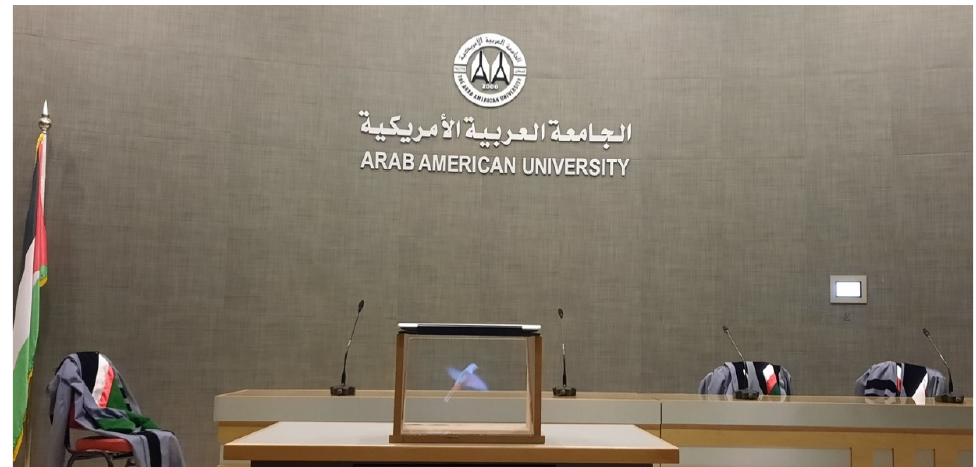
Figure 6. Demonstration of hologram experiment showing a bird.